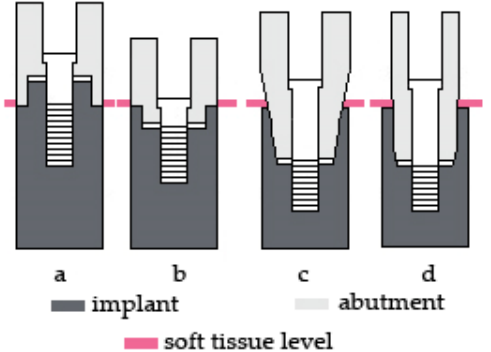
Figure 1. Types of implant-abutment connections: ( a ) External hex; ( b ) internal hex; ( c ) conical connection; ( d ) tube-in-tube connection.